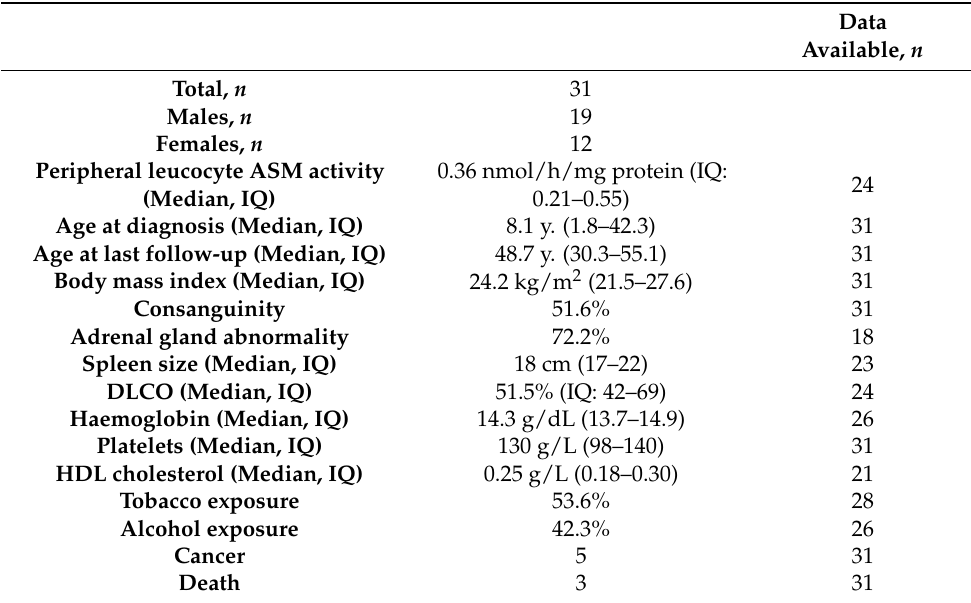
Table 1. Characteristics of CV-ASMD patients (ASM: acid